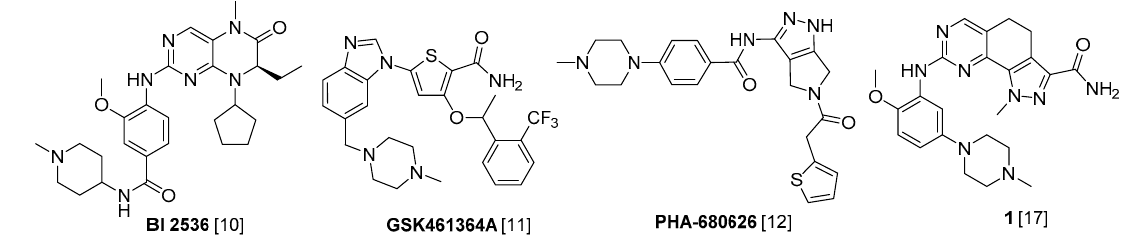
Figure 1. Representative PLK1 inhibitors.